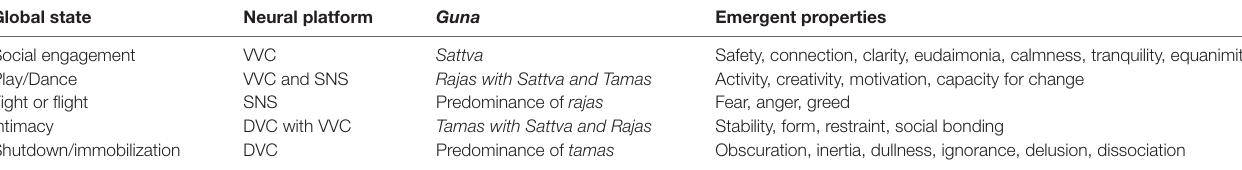
TABLE 1 | Characteristics and emergent properties of global states based on comparative neural platforms of Polyvagal Theory (PVT) and Gunas of